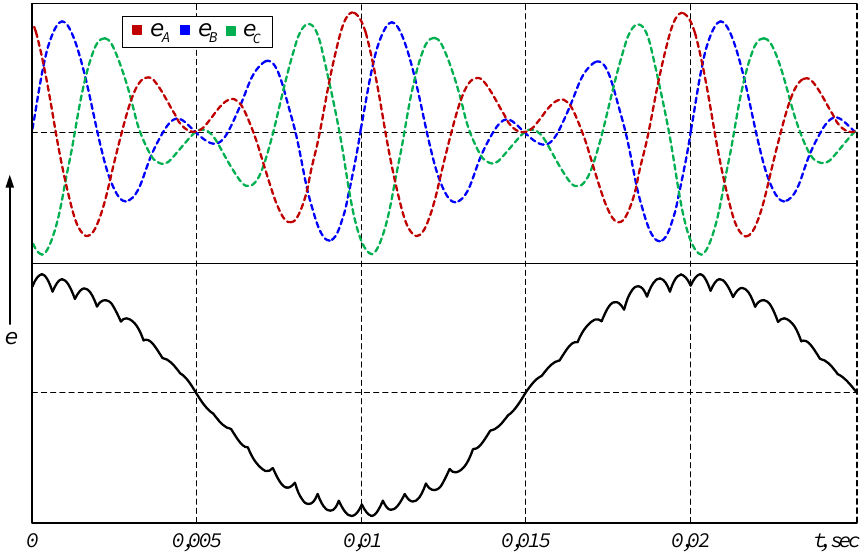
Figure. 3. Waveforms of EMFs of armature windings of SG and output voltage